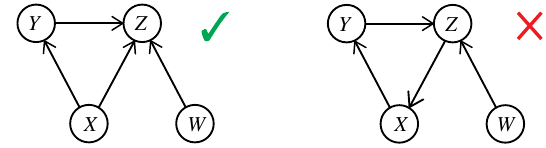
FIG. 1. In a DAG (left diagram), nodes represent random variables, and directed edges represent causal links. Closed cycles (right diagram) are